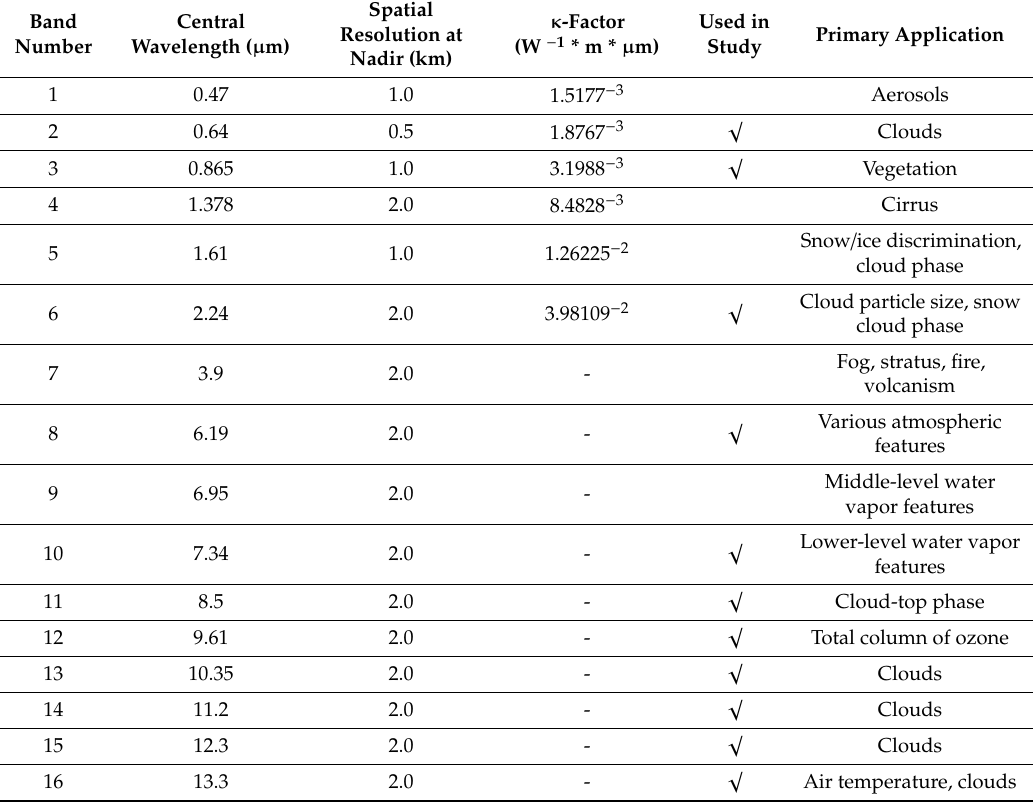
Table 1. Advanced Baseline Imager (ABI) band